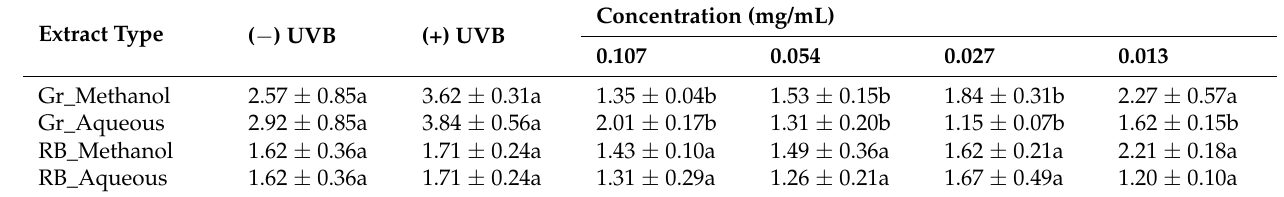
Values represent mean ± standard deviation of 4 to 5 repetitions and two independent experiments. Statistically significant differences were indicated with different lower case letters (in a row) compared to the controls ( p < 0.05). Abbreviations : ( − ) UVB—cells that were not exposed to ultraviolet-B light; (+) UVB—cells exposed to UVB light (80 mJ/cm 2